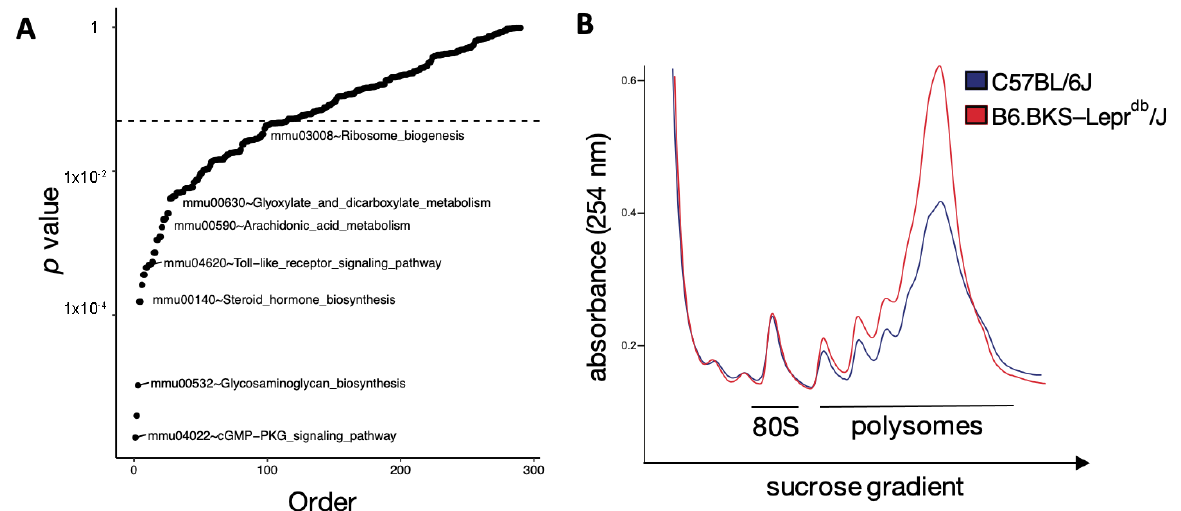
Figure 3. Translation is upregulated in the kidneys of diabetic mice. ( A ) Transcriptogram pathway analysis between diabetic and control mice. X-axis: Pathways ordered by p -values. Y-axis: − Log 10 of p -values. ( B ) Polysomal profiling of kidney extracts from diabetic and control mice. X-axis: Increasing concentration of sucrose gradient. Y-axis: Absorbance of RNA at 254 nanometers.